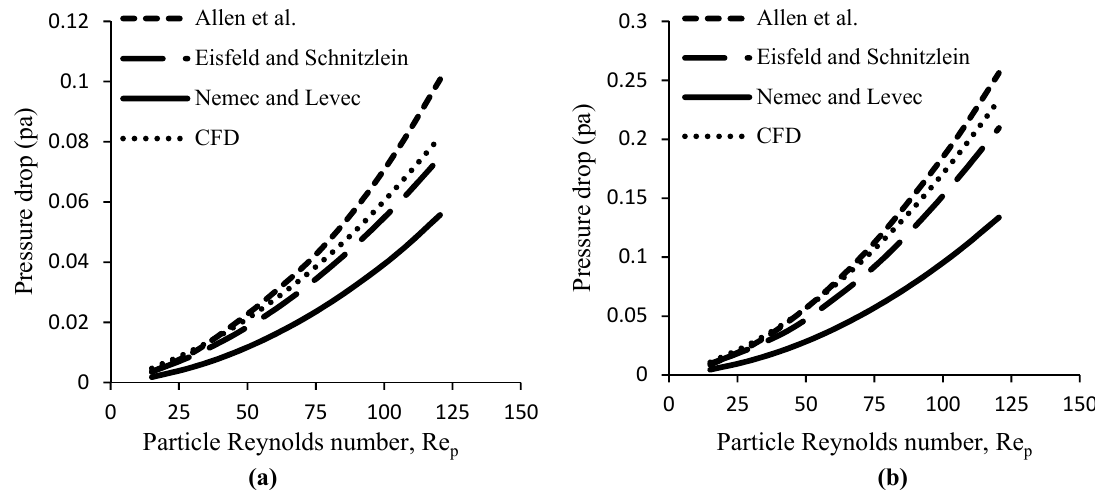
Fig. 7. Comparison of CFD pressure drop with empirical correlations for the packed bed with truncated cone particles in laminar flow: a) N=4.36 and b)